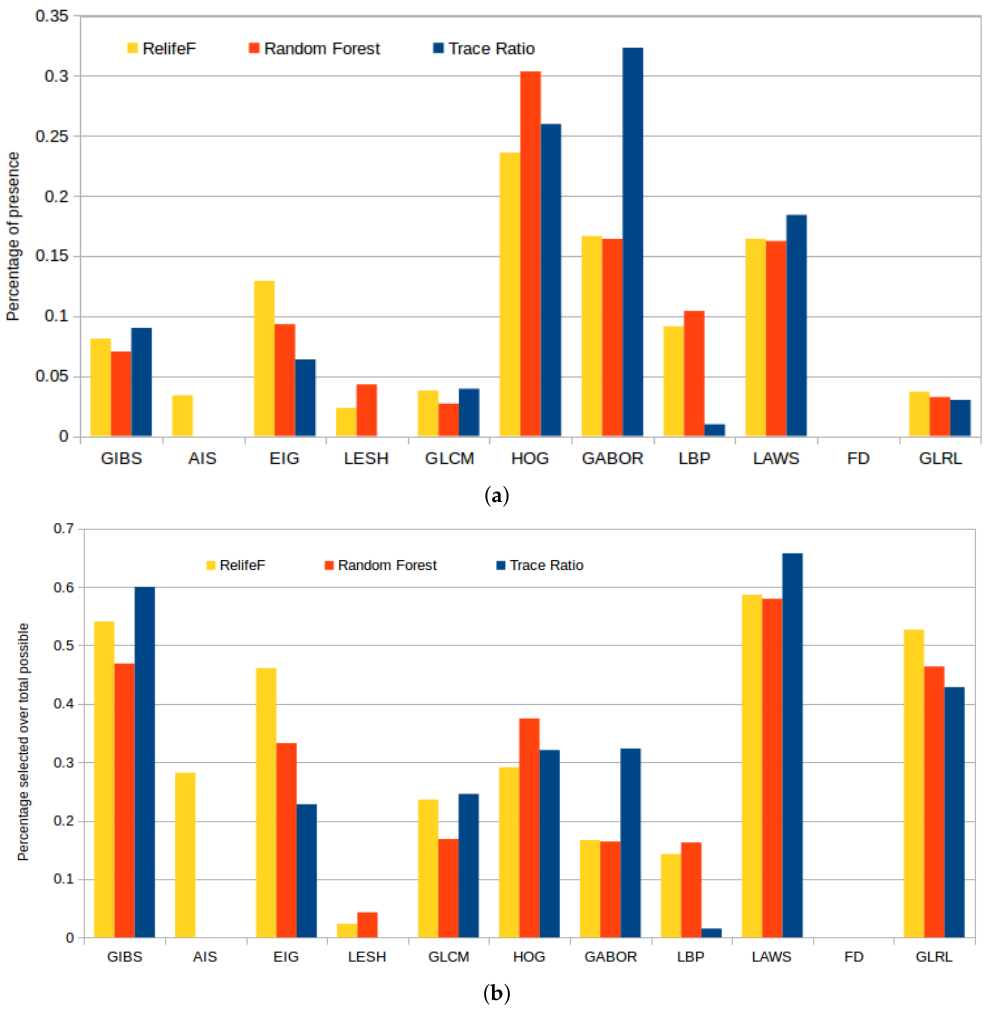
Figure 11. Percentage of presence of each family of features in the top 100 of each feature selector ( a ) and proportional percentage of selection relative to the maximum possible number of features for each family of features ( b